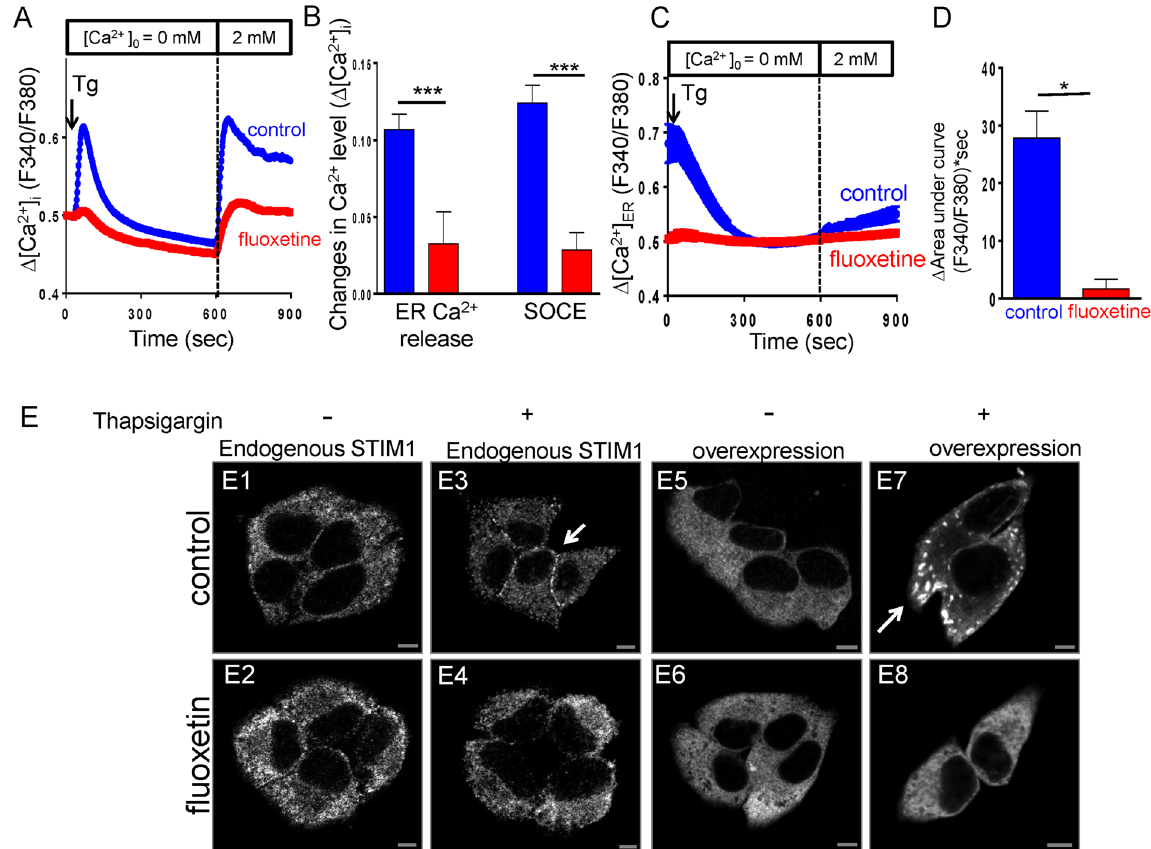
Figure 7. Fluoxetine inhibits the ER calcium release and SOCE activation. ( A ) Fluoxetine inhibits thapsigargin-induced SOCE activation. Mean traces of [Ca 2 + ] i measurement from at least 70 different cells in each experiment. The SOCE amplitude indicates the rise of [Ca 2 + ] i in replenishment of [Ca 2 + ] 0 from 0 to 2 mM. Arrow, adding 2 μ M thapsigargin (Tg). ( B ) Quantitative analyses of Δ [Ca 2 + ] i . Each value represents mean ± SEM of at least 70 individual cells. *** P < 0.001 ( C ) Representative measurements of ER Ca 2 + level ([Ca 2 + ] ER ) in MIN6 cells. Mean traces of [Ca 2 + ] ER measurement from at least 30 different cells in each experiment. ( D ) Quantitative analyses of Δ [Ca 2 + ] ER . Each value represents mean ± SEM of at least 60 cells. * P < 0.05 ( E ) Fluoxetine blocks STIM1 membrane trafficking. Representative confocal images of endogenous STIM1 or transiently expressed eGFP-STIM1 at control and after 5 min of exposure to thapsigargin (2 μ M) in MIN6 cells treated with or without fluoxetine. Scale bar, 5 μ